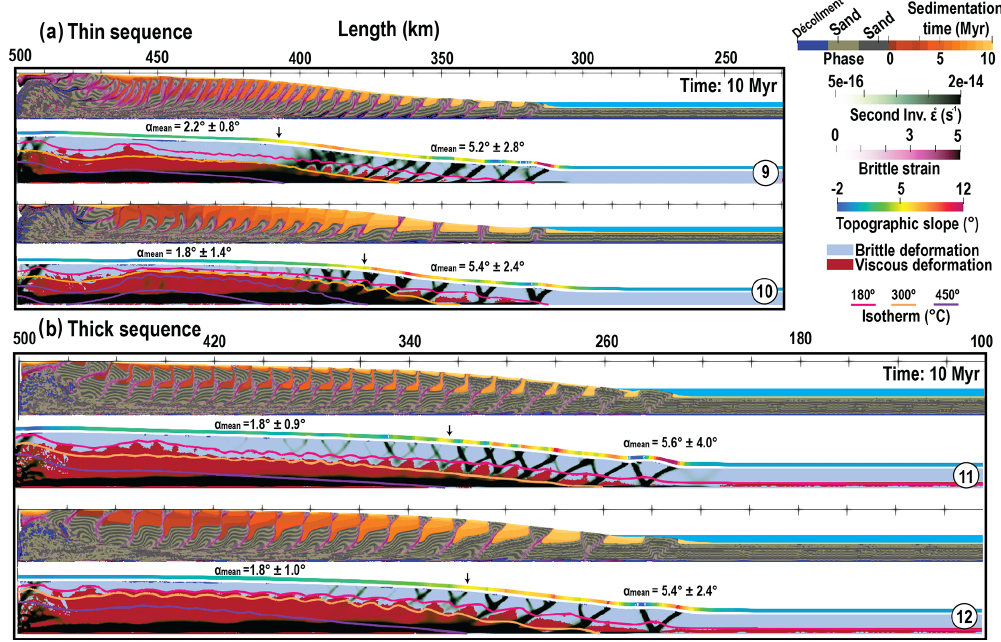
Figure 6. High temperature gradient (25 ◦ Ckm − 1 ) after 10Myr for (a) thin sequence and (b) thick sequence. M9 and M11 are with normal erosion and sedimentation rate whereas M10 and M12 indicate high sedimentation rate. Color codes and experiment parameters are given in Fig. 2 and Tables 1 and 2, 1:1